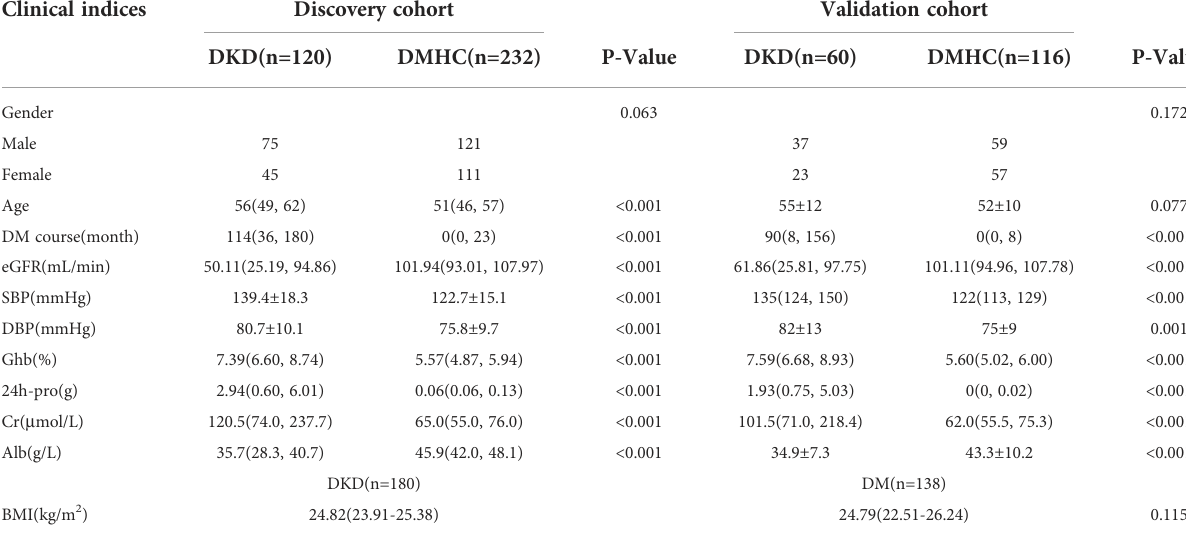
TABLE 1 Demographic characteristics of participants in discovery and validation